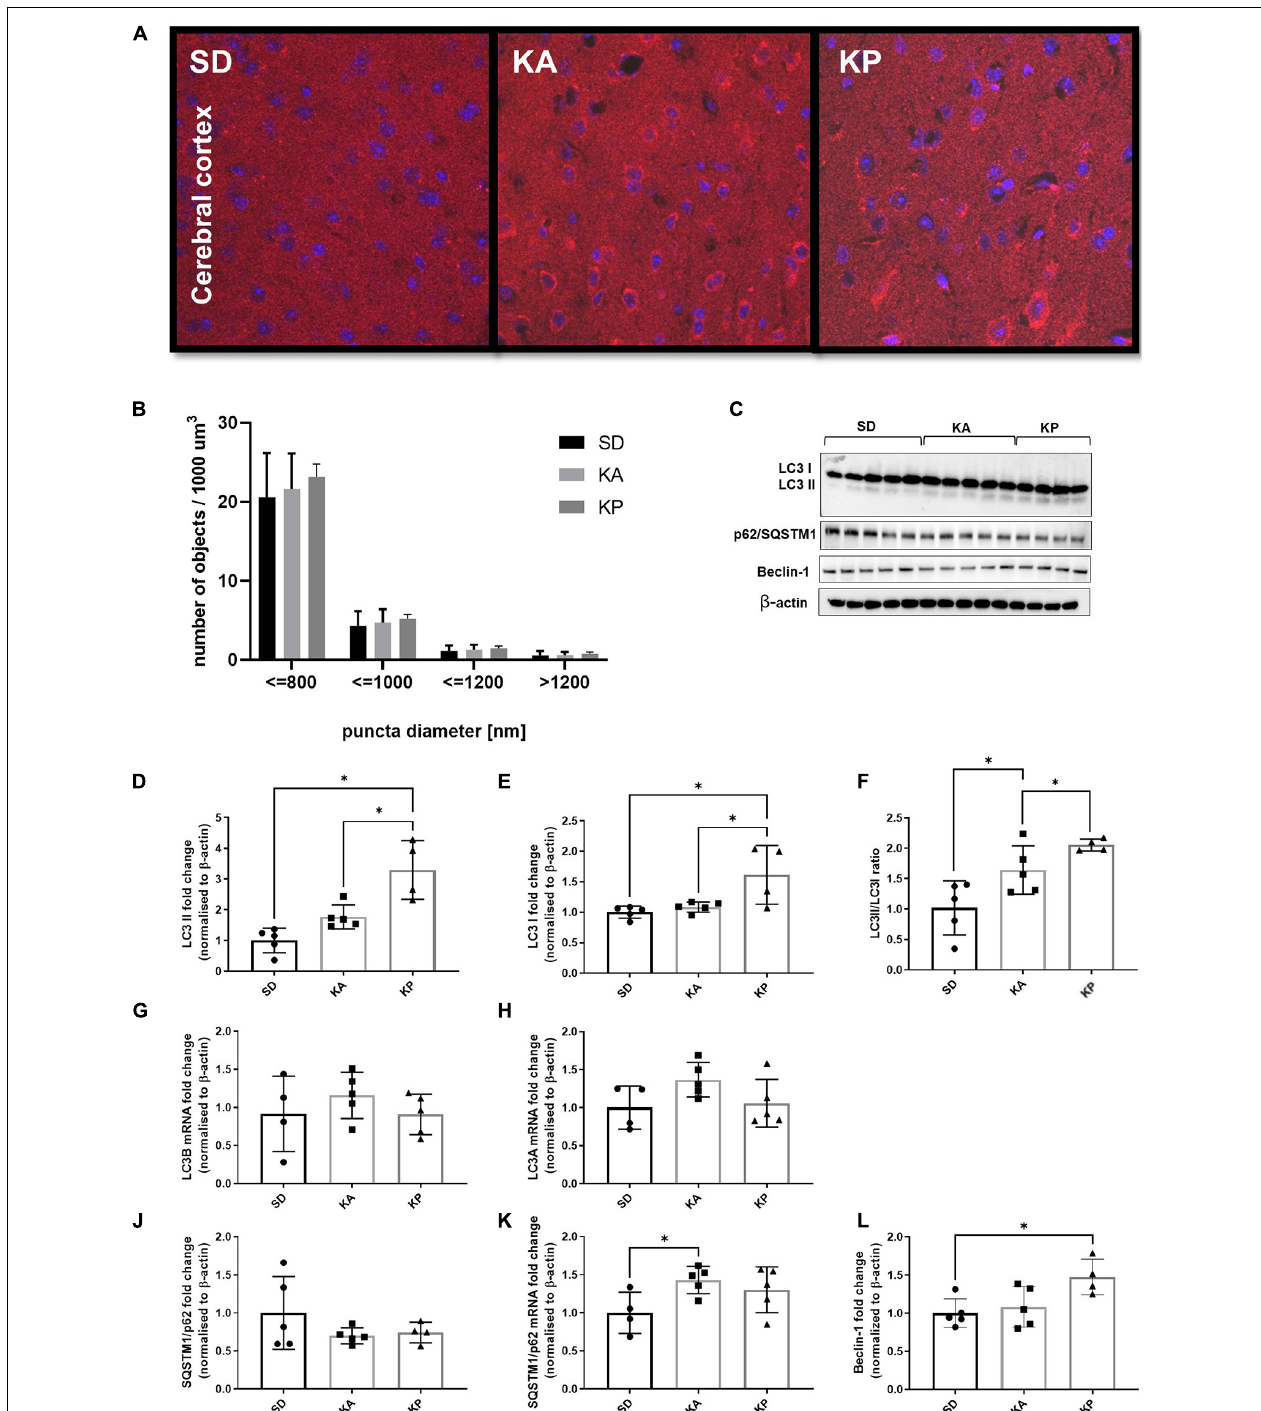
FIGURE 2 | The level of autophagy markers in the cerebral cortex of the mice fed with the ketogenic diets. (A) The cortices were immunolabeled against LC3 protein (red) and the level of LC3-positive puncta was counted ( n = 5). The nuclei are shown in blue (DAPI). (B) Number of LC3 puncta per 1 µ mˆ3 of tissue; the counted objects were divided into four categories based on their diameter. (C) LC3, SQSTM1/p62, and Beclin-1 with matched β -actin blots. Quantification of (D) LC3-II, (E) LC3-I protein levels and (F) its ratio. (G) Quantification of LC3 A and (H) LC3 B mRNA levels. (J) Quantification of SQSTM1/p62 and (K) its mRNA level. (L) Quantification of Beclin-1 level. The data is presented as a mean ± standard deviation, ∗ indicates statistically significant changes ( p < 0.05). SD marks a group of control animals fed with standard chow, while experimental mice were maintained on the ketogenic diet composed of fat of animal (KA) or plant (KP) origins.